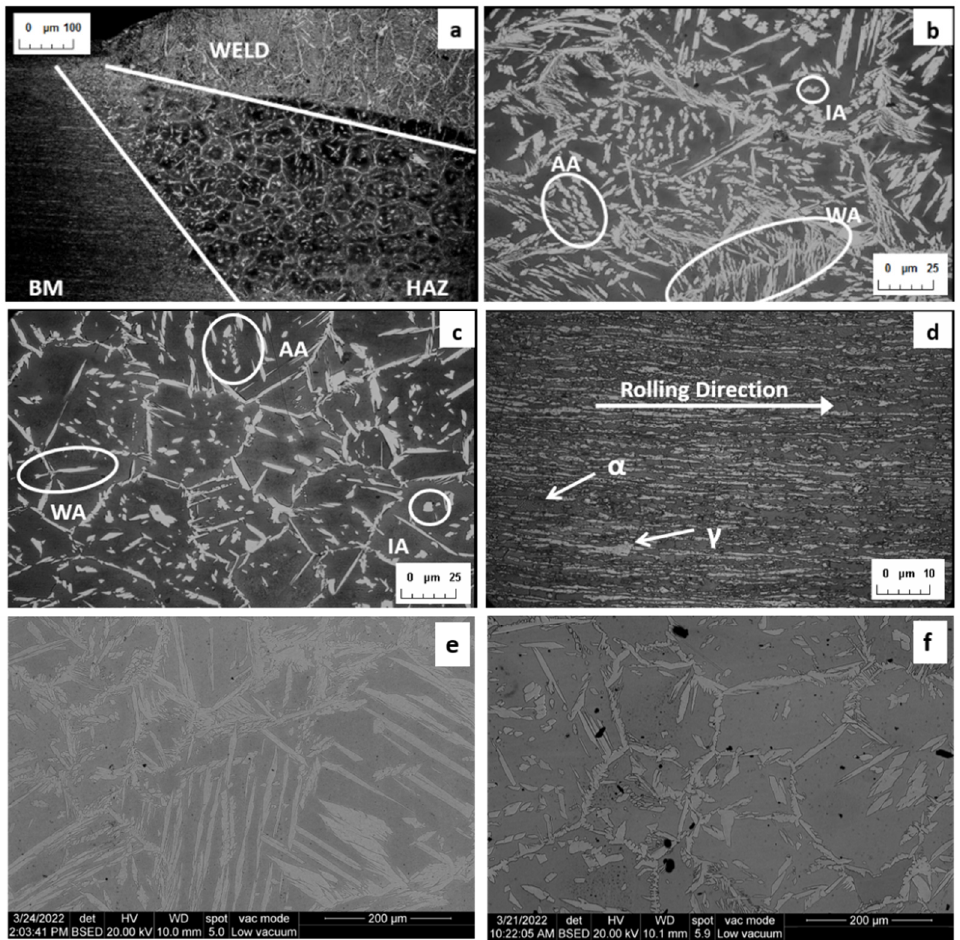
Figure 4. Microstructure obtained on weld coupon 3. ( a ) The three types of microstructure are shown: bead, HAZ, and BM (base metal), ( b ) weld bead, ( c ) HAZ, ( d ) base metal, SEM images ( e ) of the weld bead, ( f ) of the HAZ.